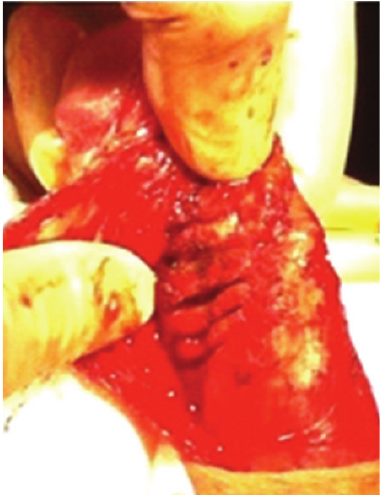
Figure 1: Incision in the calcified 4 × 2cm plaque.